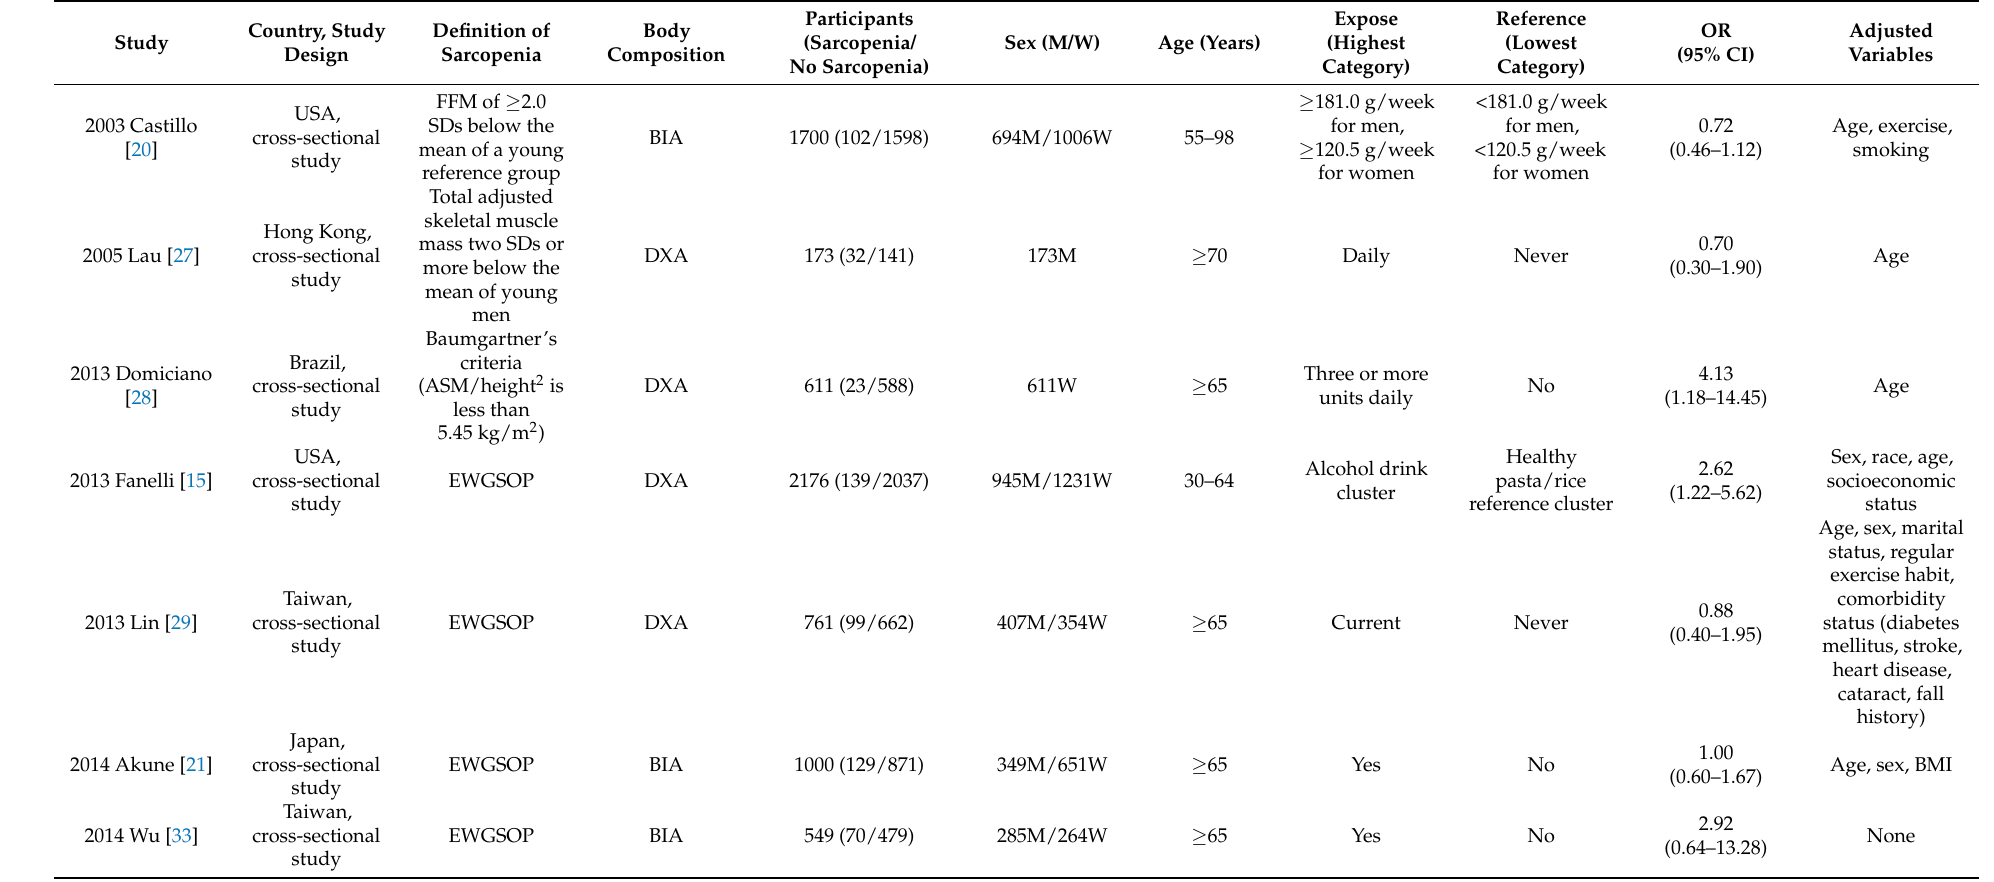
Table 1. Characteristics of the included